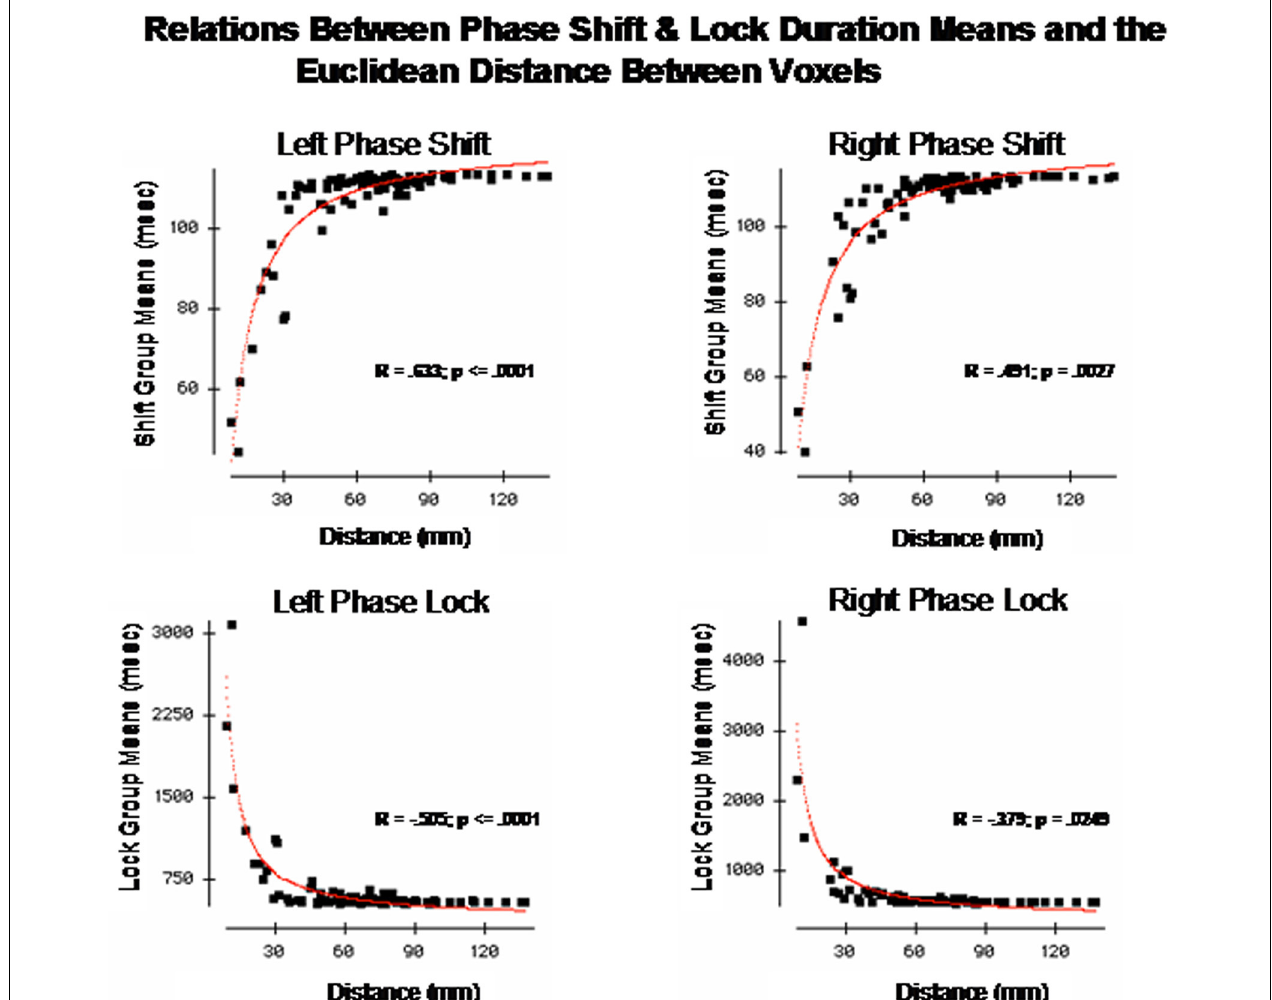
FIGURE 5 | The x-axis is the Euclidean distance between the center voxels that comprise the DMN Brodmann areas as described in Table 1. The y-axis is phase shift duration (Top) and phase lock duration (Bottom) of the Brodmann areas described in Table 1 . The left row are the left hemisphere Brodmann areas and the right row are the right hemisphere Brodmann areas. The red line is the fit of an exponential equation